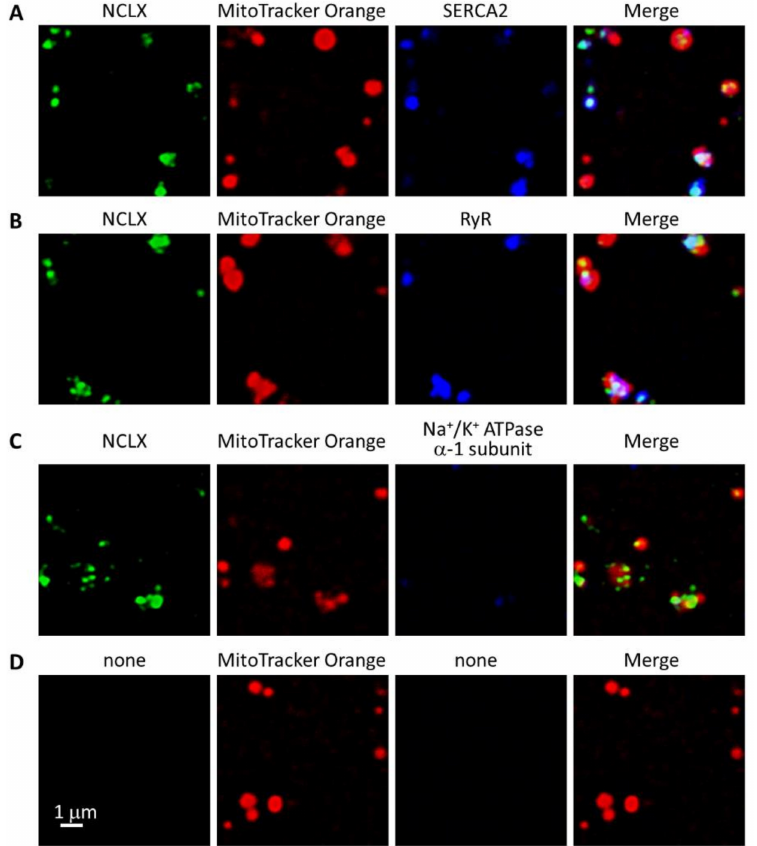
Figure 3. Immunofluorescence analyses of mitochondria isolated from mouse ventricle. Mitochondria loaded with 1 µ M MitoTracker Orange CMTMRos were co-immunostained with anti-NCLX antibody and anti-SERCA2 ( A ), anti-RyR ( B ), and anti-Na + /K + ATPase α -1 subunit ( C ) antibodies. NCLX- derived Alexa Fluor 488 signals are shown as green, MitoTracker Orange CMTMRos-derived signals are red, and SERCA2-, RyR-, and Na + /K + ATPase α -1 subunit-derived Alexa Fluor 633 signals are blue. Merged images are shown in the rightmost panels. As a negative control, 1 µ M MitoTracker Orange CMTMRos-loaded mitochondria, which was incubated with secondary antibodies but not with primary antibody, are shown in ( D